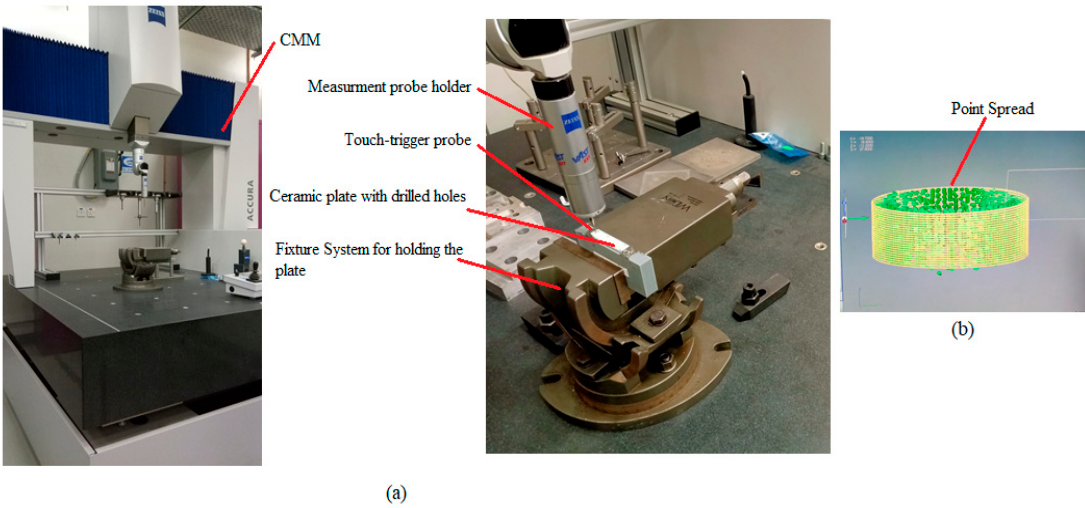
Figure 6. ( a ) Coordinate measuring machine (CMM) measurements system and ( b ) measurement point coverage.